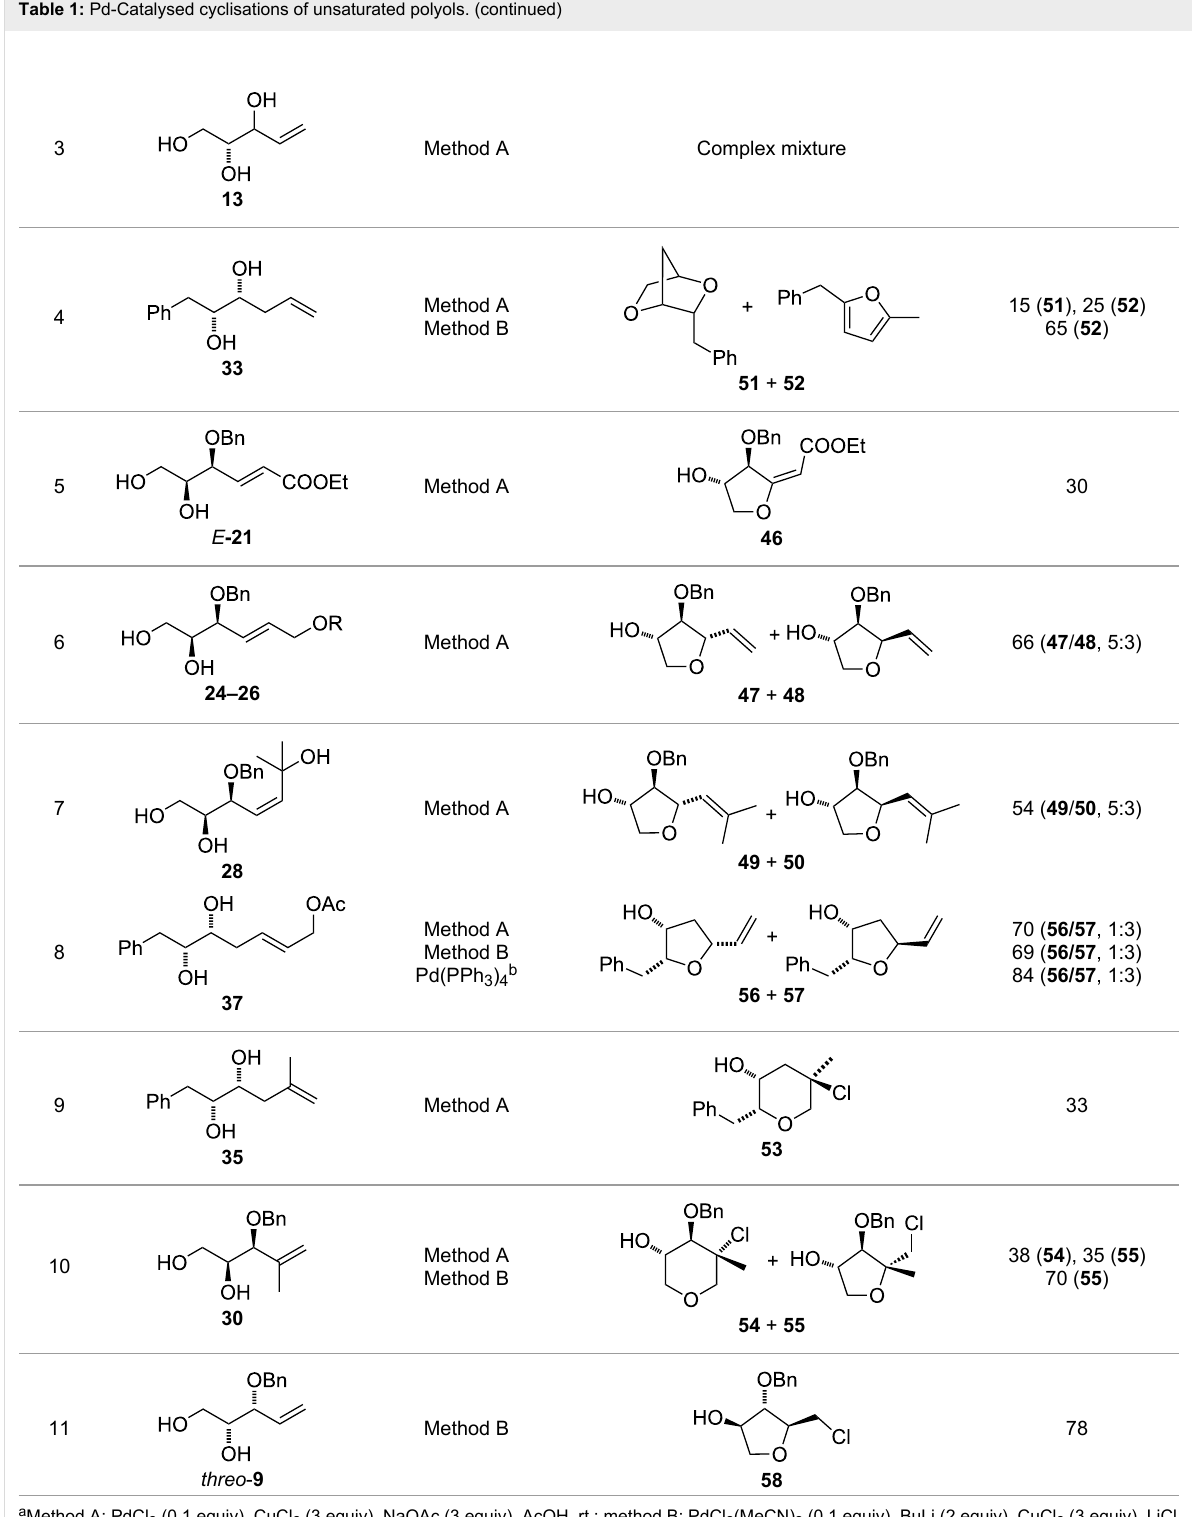
Table 1: Pd-Catalysed cyclisations of unsaturated polyols.